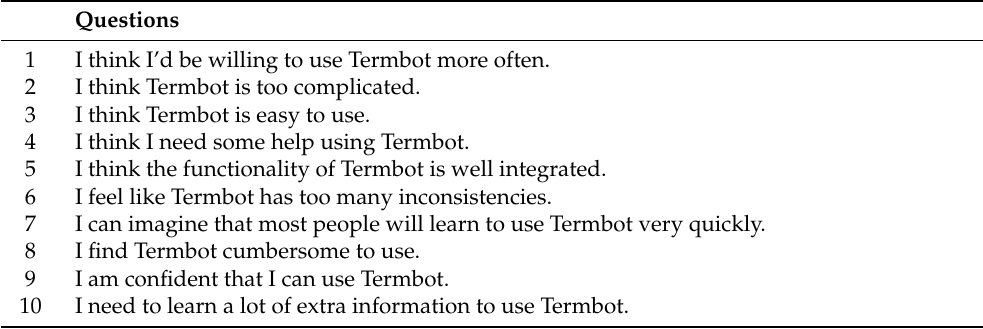
Table 1. The SUS